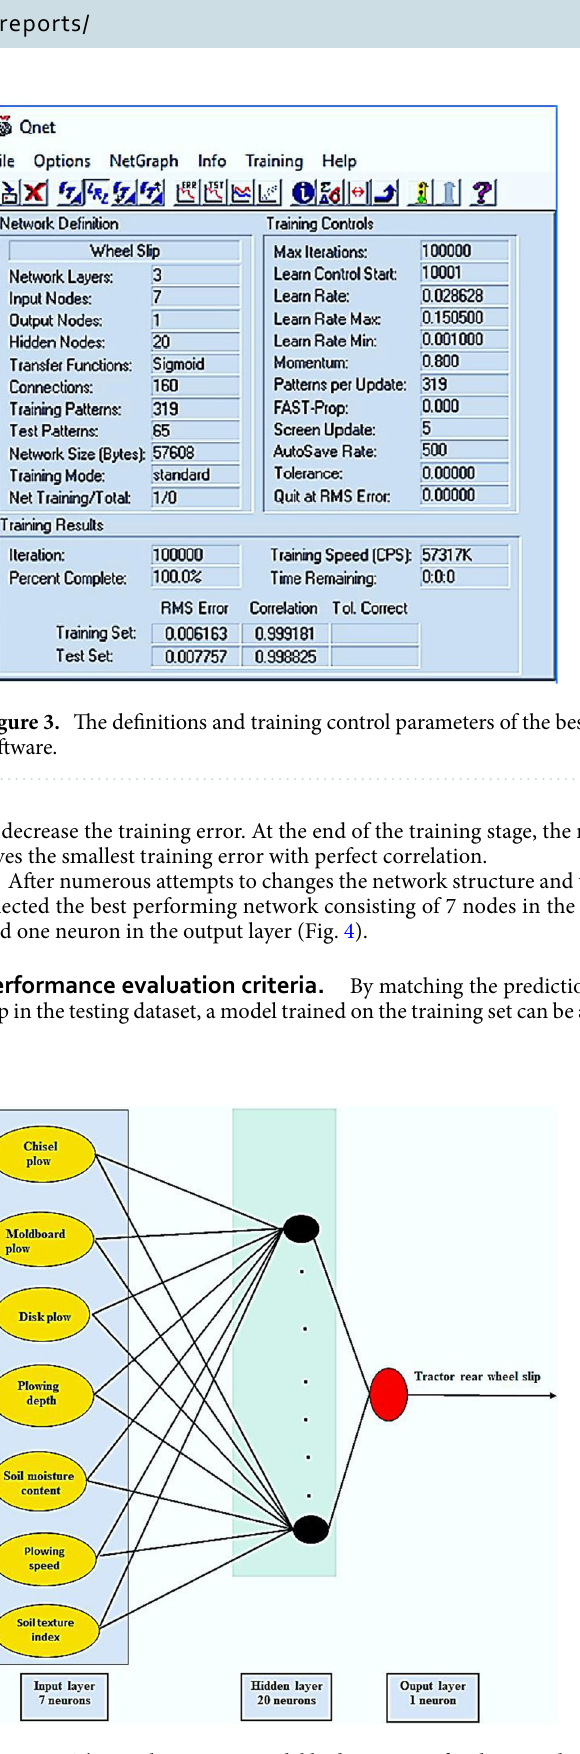
Figure 4. The resulting ANN model had 7 neurons for the input layer, 20 neurons for the hidden layer, and one neuron for the output